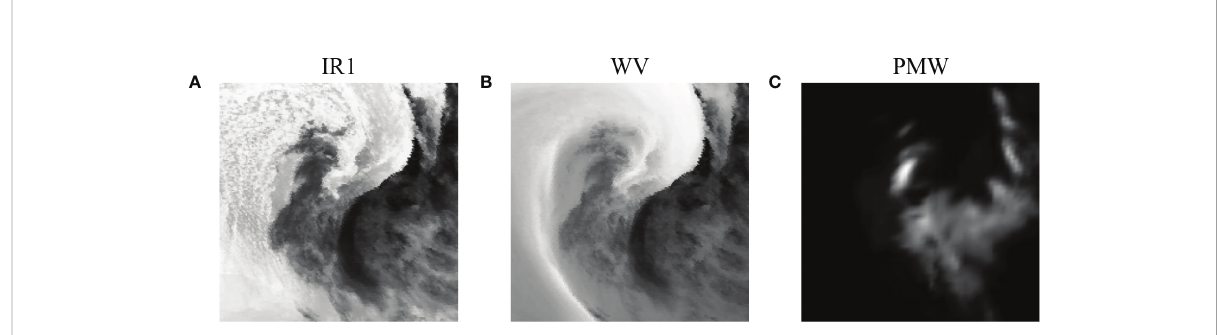
FIGURE 1 Examples of three channels from TCIR. They are scaled to the range [0, 256) and presented in